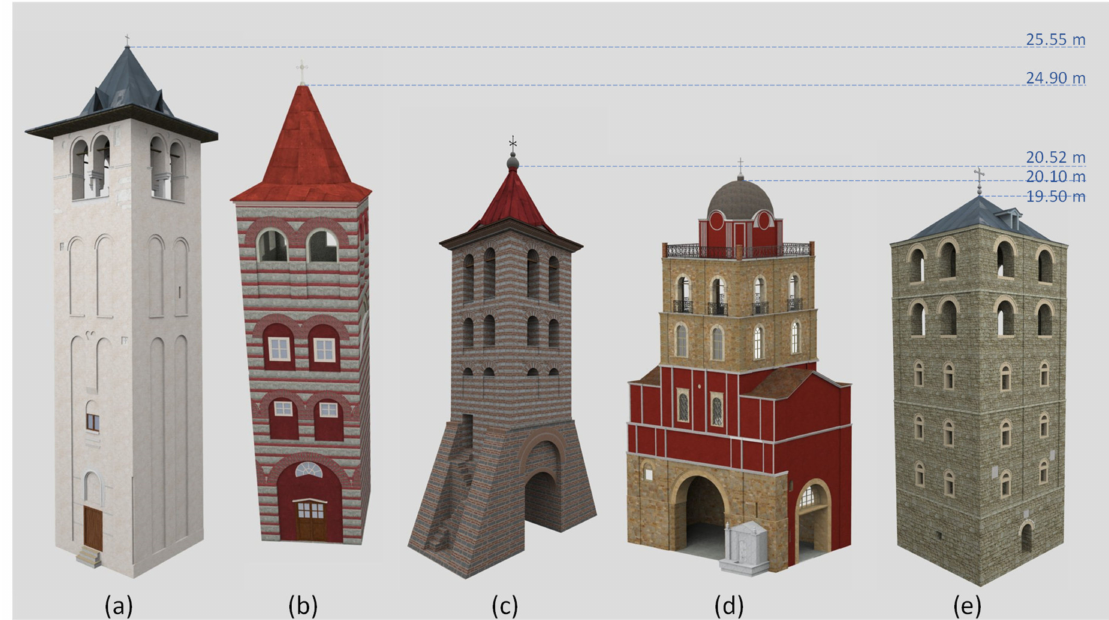
Figure 1. Byzantine bell-towers under investigation: ( a ) Vatopedi, ( b ) Philotheou, ( c ) Protaton, ( d ) Xenophontos, and ( e )